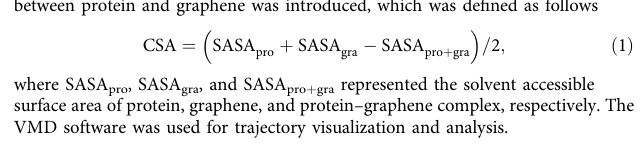
between protein and graphene was introduced, which was de fi ned as follows